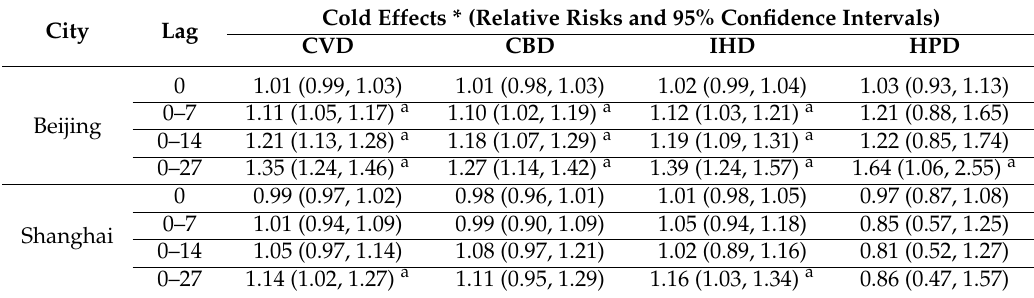
Table 4. The cumulative cold effects on cardiovascular disease, cerebrovascular disease, ischemic heart disease and hypertensive disease of Beijing and Shanghai, China. City Lag